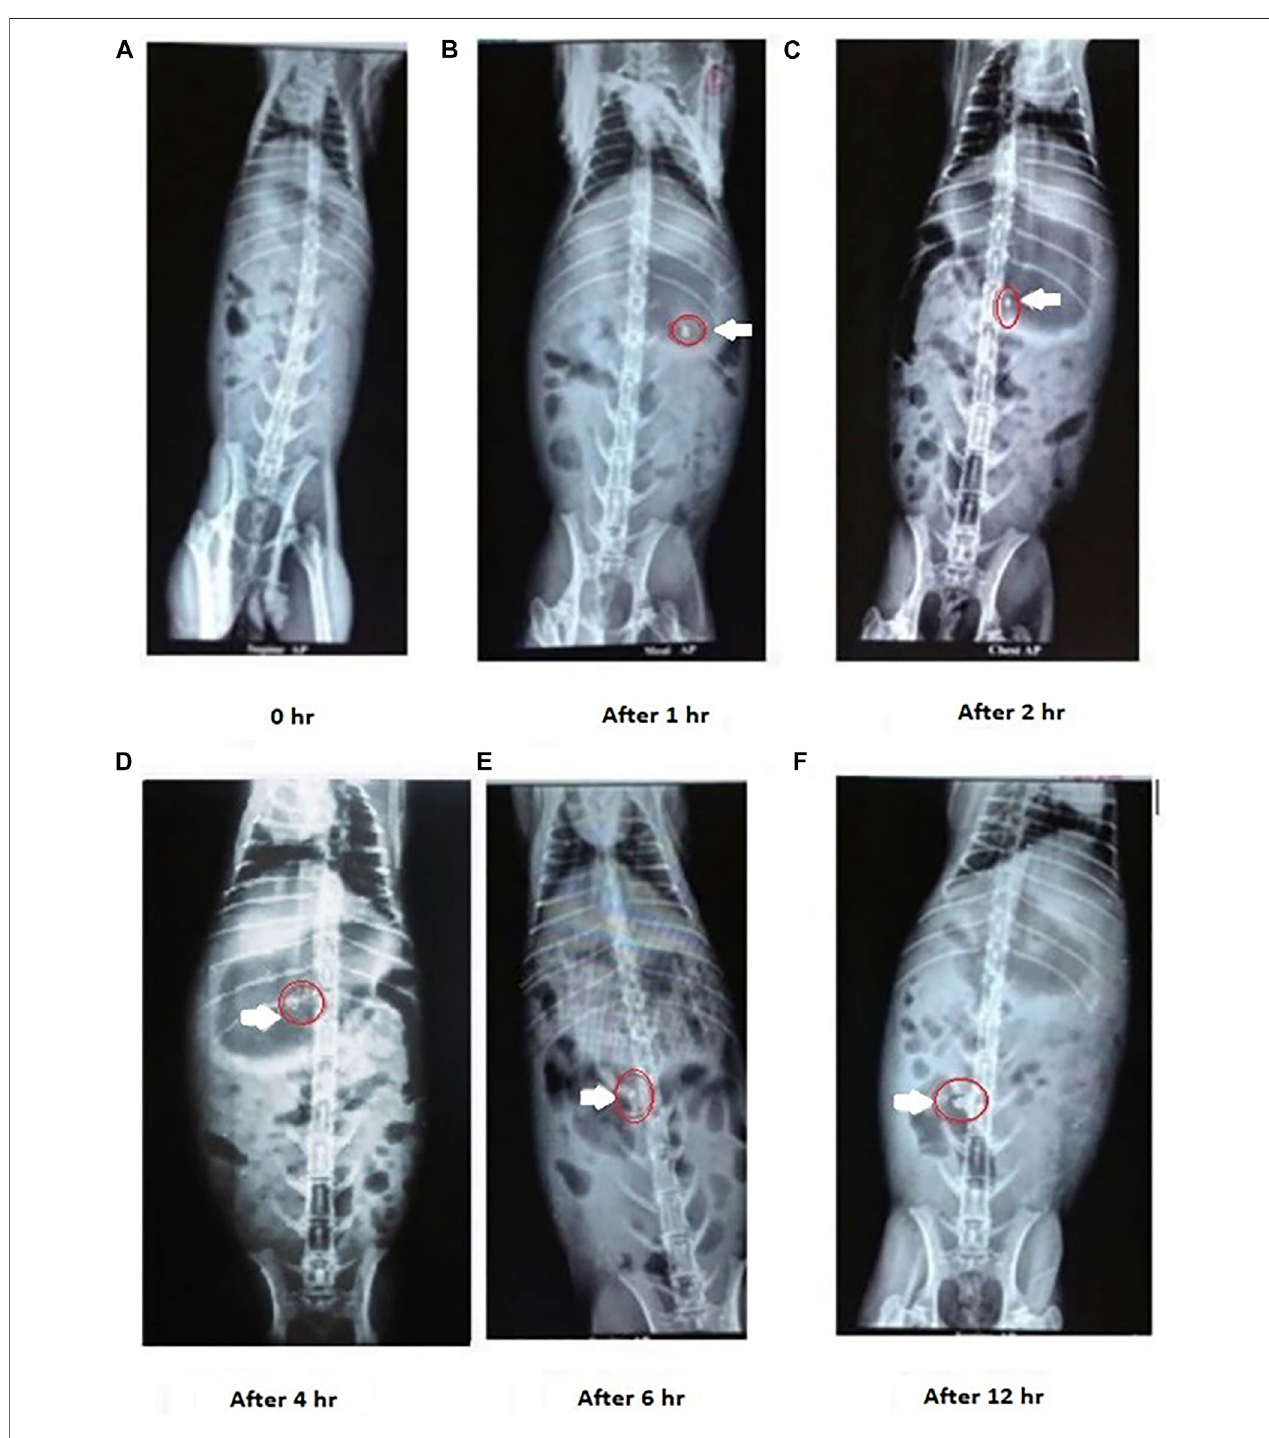
FIGURE9| X-rayimagesofCMNcolontargetingstudiesafteradministrationofM14mucoadhesivetabletformulation.Thetabletremainedintactinthegastricand upper intestinal region, On the other hand swelling and distortion in the shape of the tablet were observed in the colonic region.